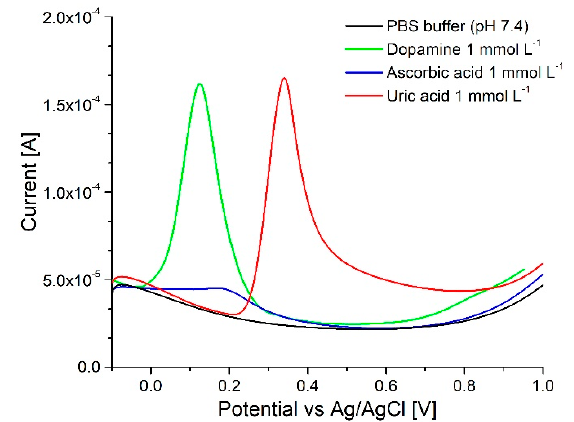
Figure 6. Square wave voltammetry of equimolar solutions of dopamine (green), uric acid (red) and ascorbic acid (blue) recorded using the array device. Array of 16 posts, flow of 100 µL min − 1 , pencils oxidized at constant potential in PBS.